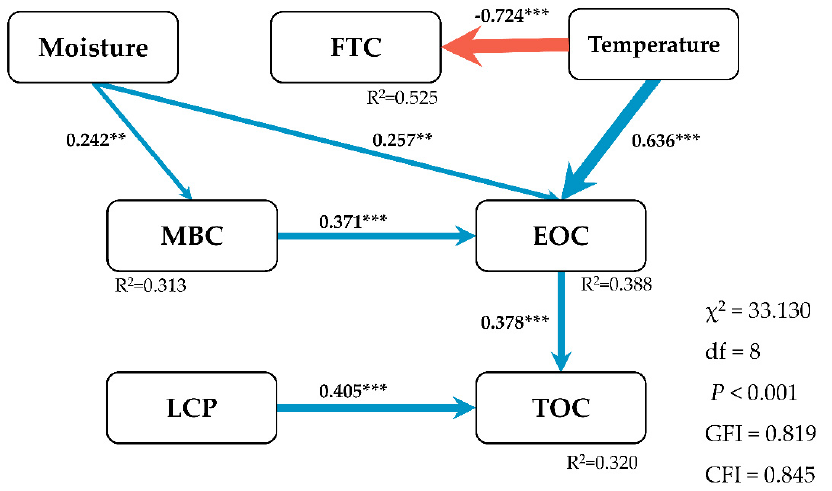
Figure 4. Structural equation model (SEM) describes multivariate effects of environmental factors and SOC pools on the soil total organic carbon (TOC). FTC, number of freeze-thaw cycles; MBC, microbial biomass carbon; EOC, easily oxidizable carbon; LCP, labile carbon pool; χ 2 , chi-square; P , probability level; df, degrees of freedom; GFI, goodness of fit index; CFI, comparative fit index. Blue and red arrows indicate positive and negative relationships, respectively. Numbers next to arrows represent standardized regression weights (** p < 0.01, *** p < 0.001), the magnitudes of which are proportional to the thickness of the arrows. R 2 values alongside each variable represent the estimates of multiple correlations, interpreted as proportion of variance explained for a given response variable. Table 4. Results of three-way RANOVA showing the p -values concerning the effects of sampling time (T), forest type (F), litter treatment (L), and their interactions on soil organic carbon fractions.